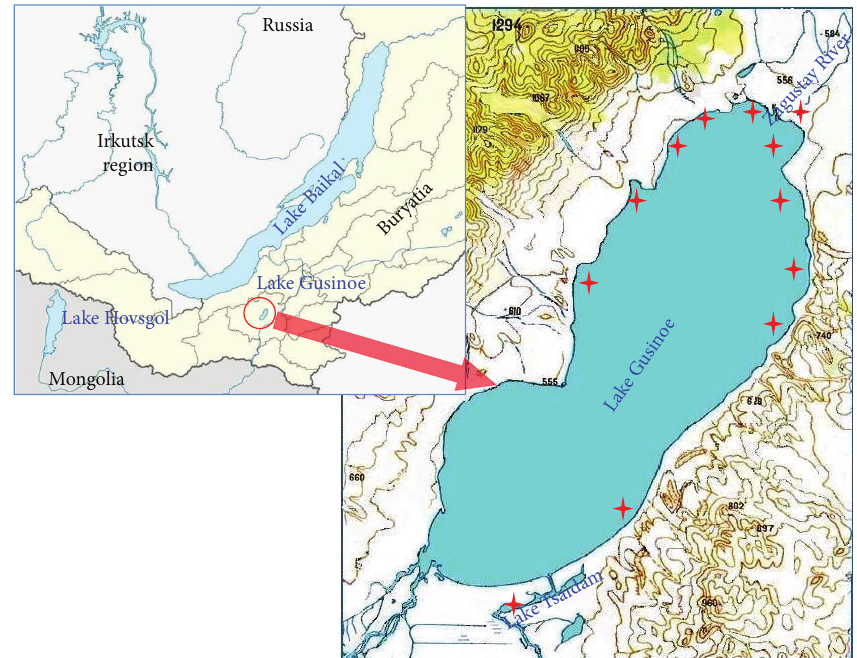
Figure 1: Geographical location of the study region with indication of the main sampling sites in Lake Gusinoe, Lake Tsaidam, and Zagustay